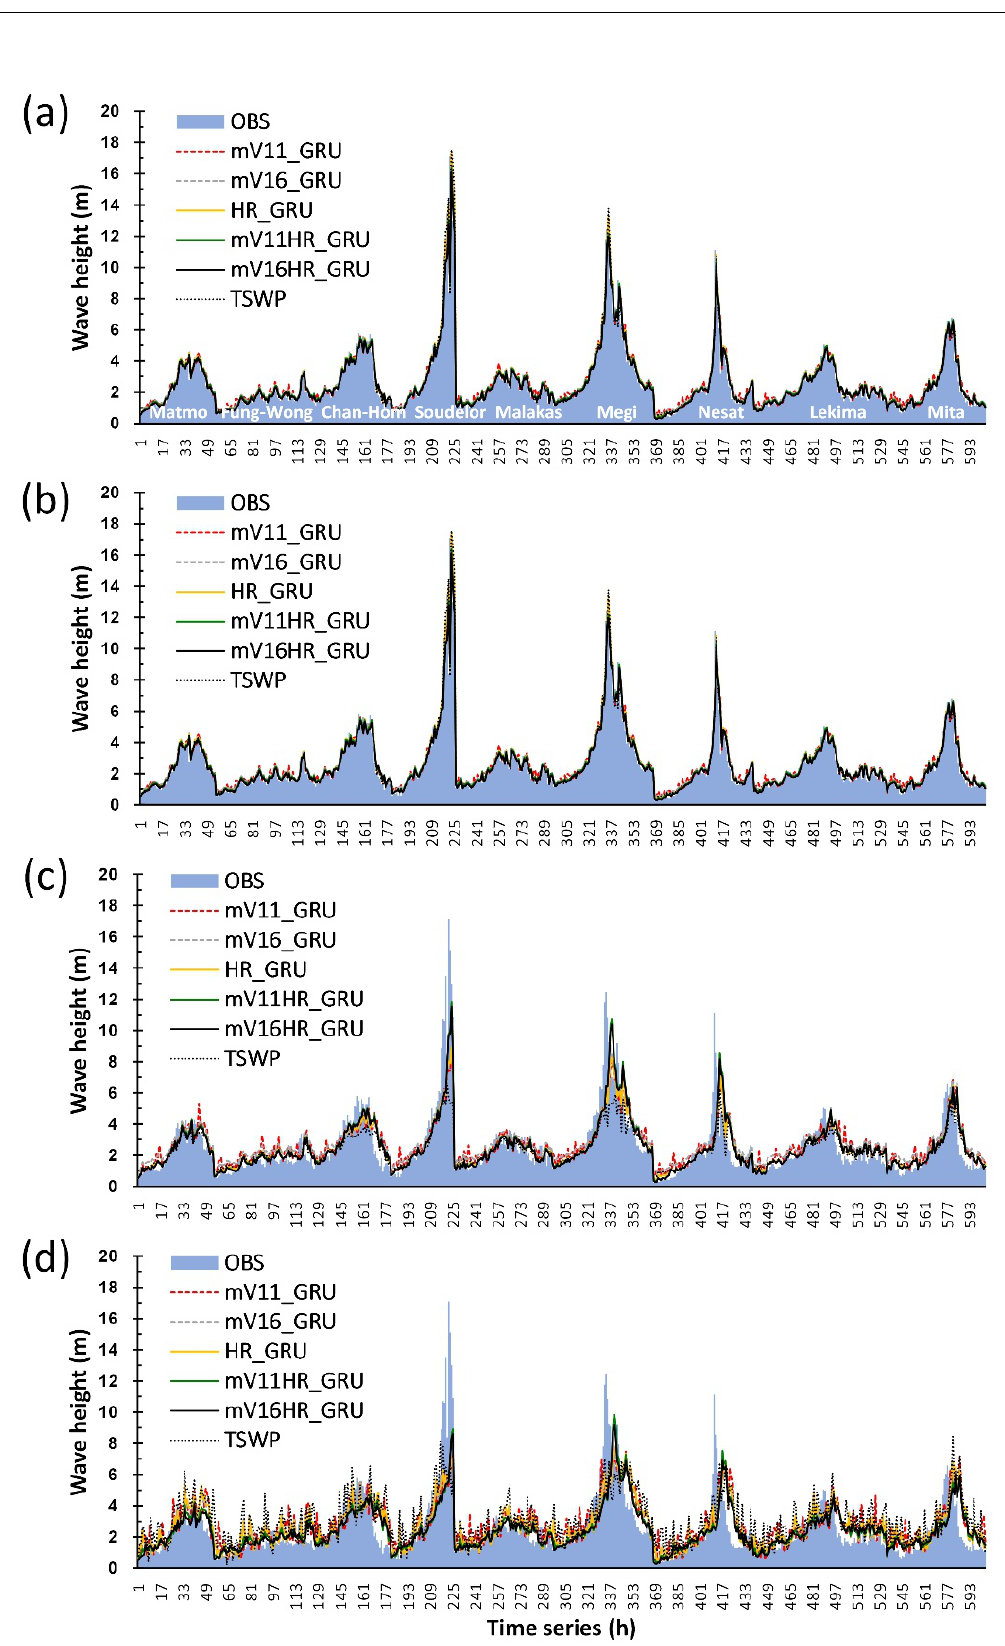
Figure 8. Wave heights predicted and measured using mV11_GRU, mV16_GRU, HR_GRU, mV11HR_GRU, mV16HR_GRU, and TSWP at the Longdong buoy at the following lead times: ( a ) t + 1, ( b ) t + 2, ( c ) t + 4, and ( d ) t + 6.